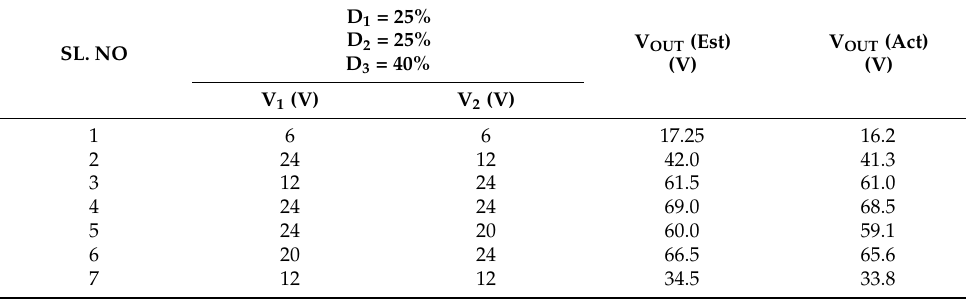
Table 3. Comparison table for the output voltage with fixed duty cycles in unidirectional